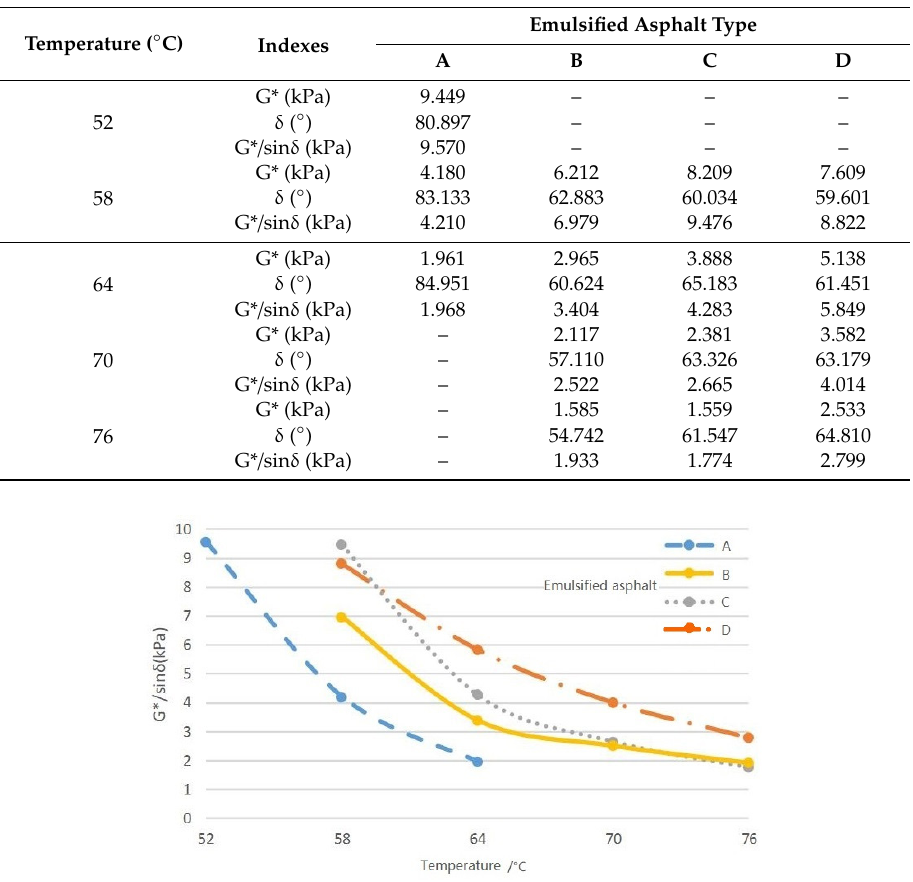
Table 4. Results of time sweep test.